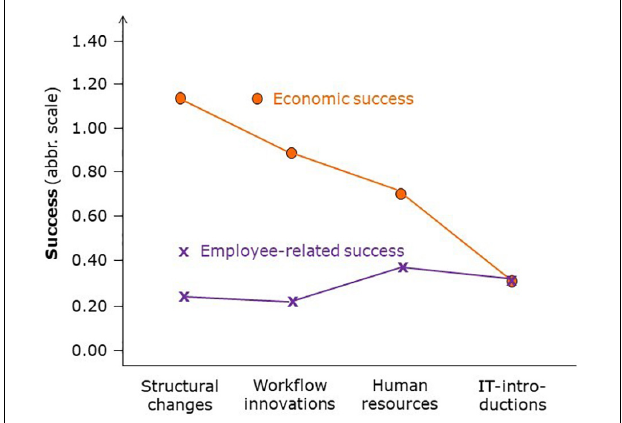
FIGURE 2 | Average economic and employee-related success in the four innovation types.